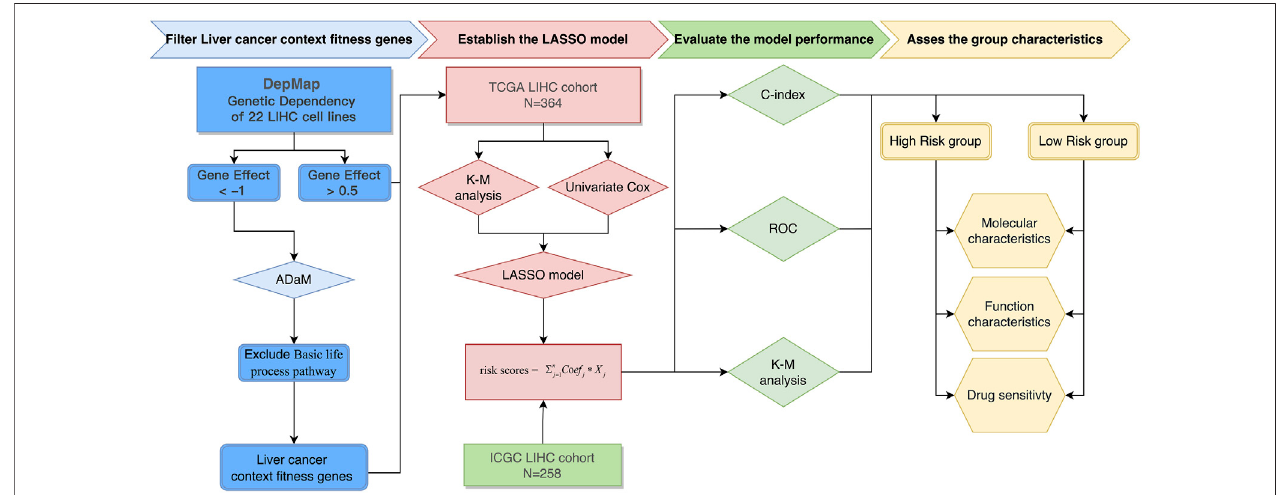
FIGURE1| Flowchartoftheentireanalysis.Flowchartoutliningthestepsinvolvedinfabricatingrobustprognosticmodelsfromlivercancercontext-speci fi c fi tness genes.